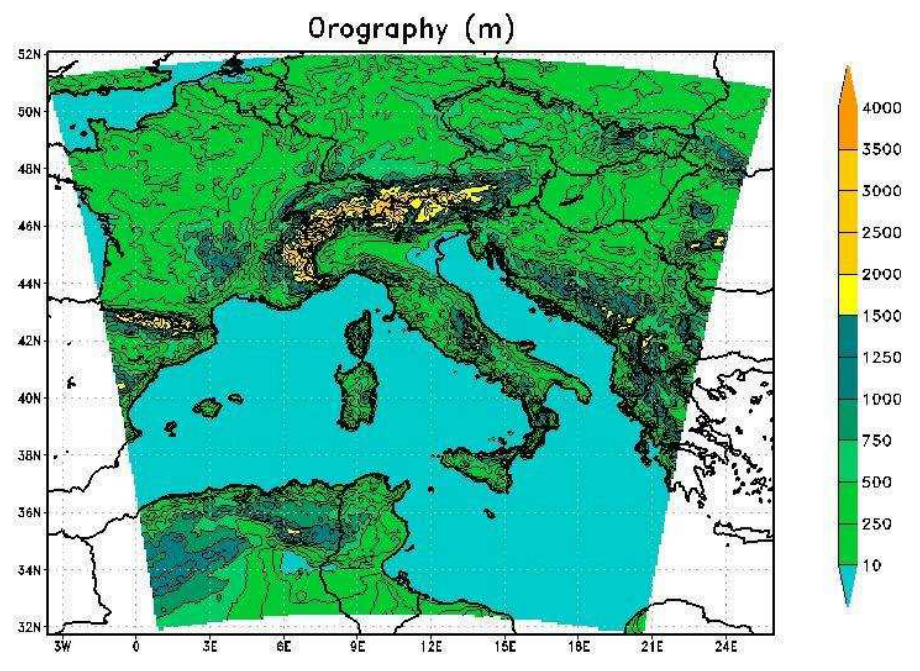
Figure 1. COSMO-I7 domain and orography description. Fig. 1. COSMO-I7 domain and orography description.